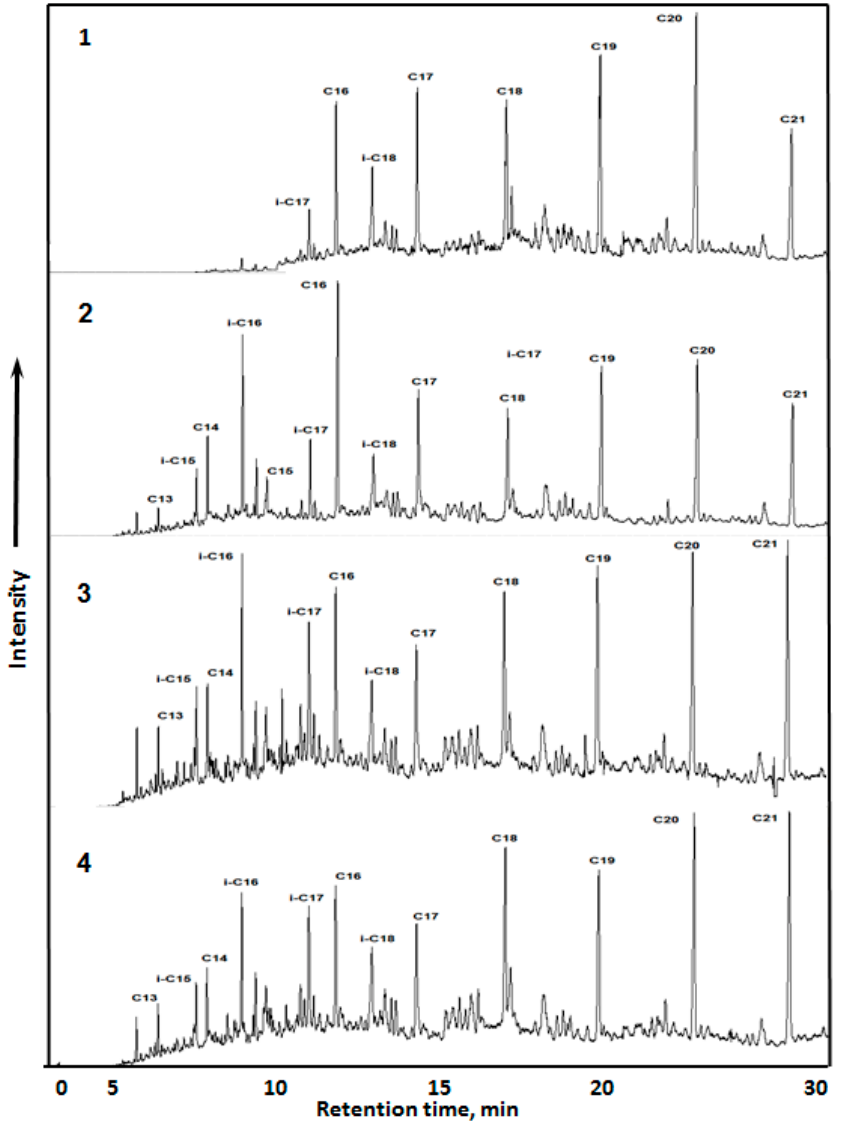
Figure 6. Chromatograms of the saturated fraction of the investigated samples of extracts: initial (1) and experimental products (2,3,4).